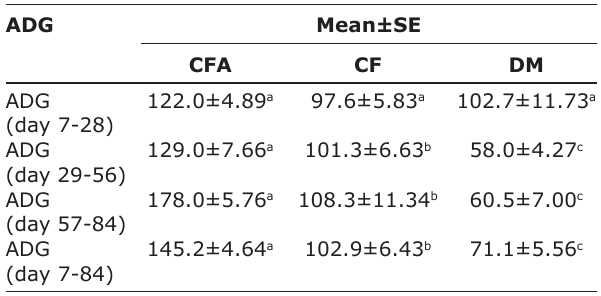
Table-3: ADG (g/day) of kids from DM, CF and CFA treatment groups (n=16) at different age periods.